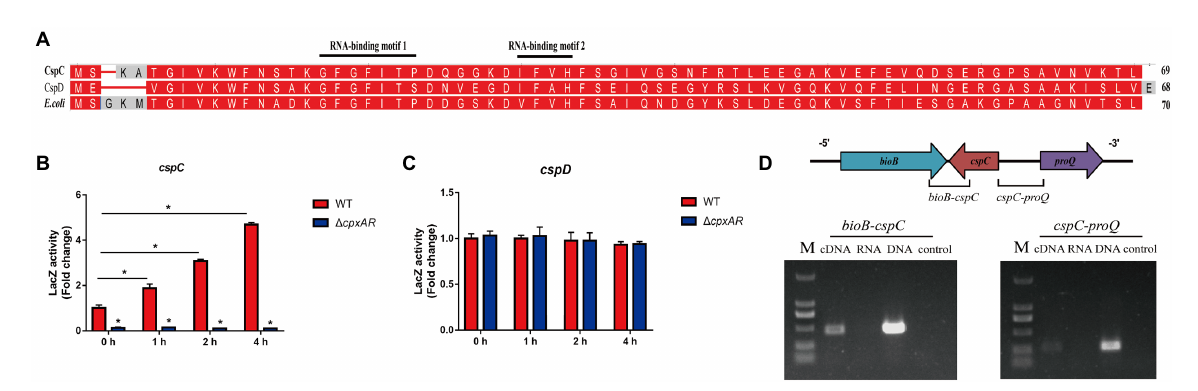
FIGURE 2 cspC transcription is activated by CpxR. (A) Alignment of cold shock proteins homologs showing the conserved cold shock domain (CSD), which harbors two nucleic acid-binding motifs RNAP1 and RNAP2. The A. pleuropneumoniae CspC and CspD, and E. coli CspA are included for comparison. Promoter activity of cspC (B) and cspD (C) genes in the WT, ∆ cpxAR and C ∆ cpxAR strains under 20 ° C. * p < 0.05. (D) Transcriptional characteristics of cspC gene as determined by RT-PCR at 20 ° C.